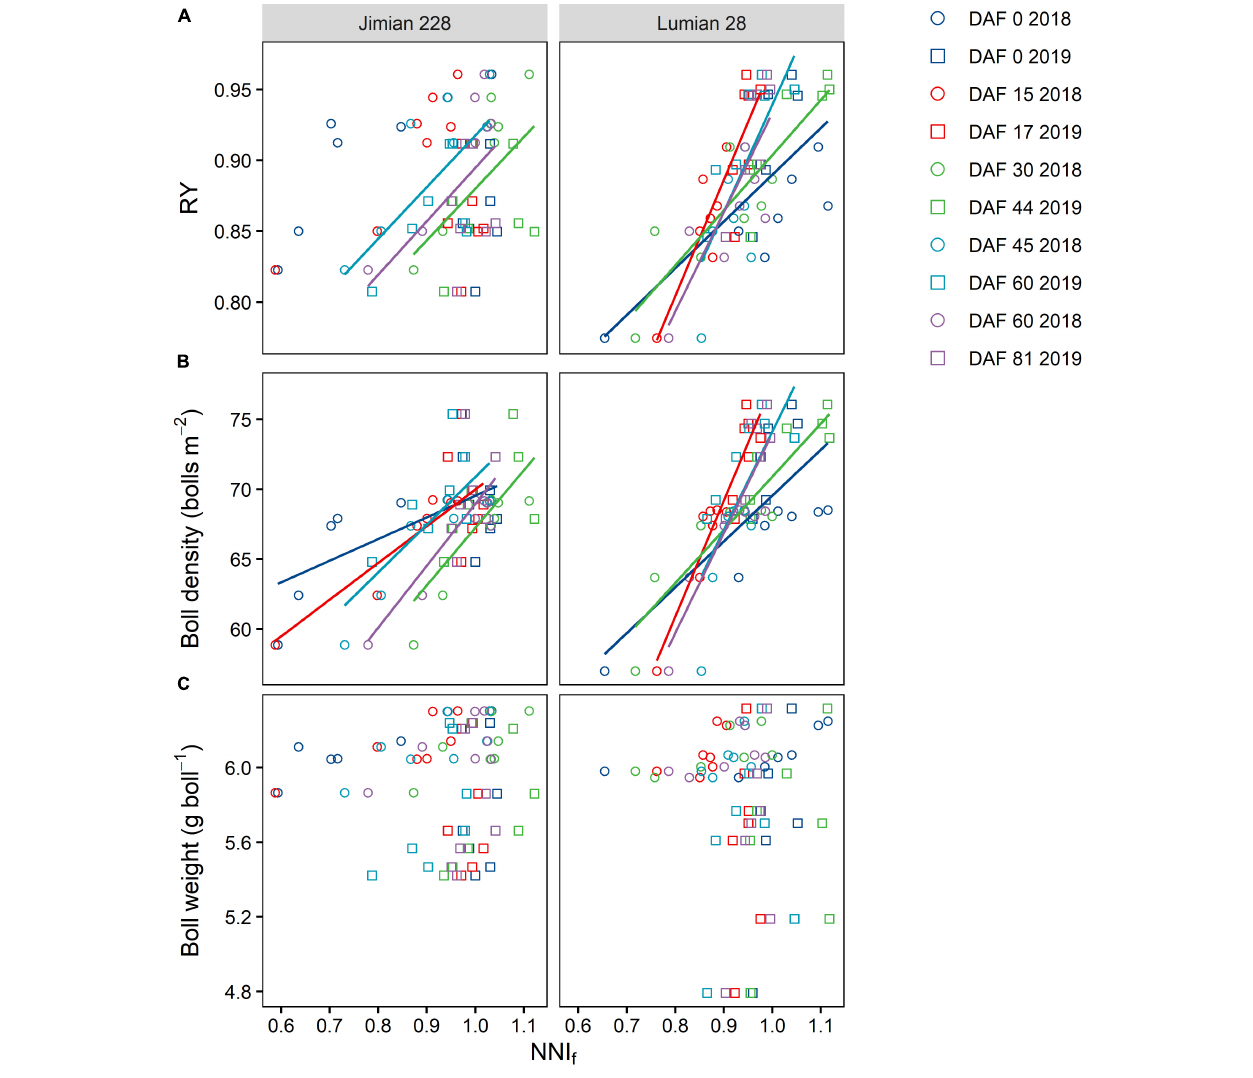
FIGURE 7 | The relationships of RY (A) , boll density (B) , and boll weight (C) with the fruits nitrogen nutrition index (NNI f ) for each cultivar at each sampling date. RY, relative yield; DAF, days after flowering; and the NNI f is calculated as the ratio between the actual fruits N concentration and the critical fruits N concentration. Calculation for relative yield is presented in section “Materials and Methods.” Different symbols indicate mean values of the three replicate plots. The color solid lines represent significant linear relationships ( P < 0.05) for Jimian 228 and Lumian 28 at each sampling time across 2 years; non-significant relationships are not shown ( P >